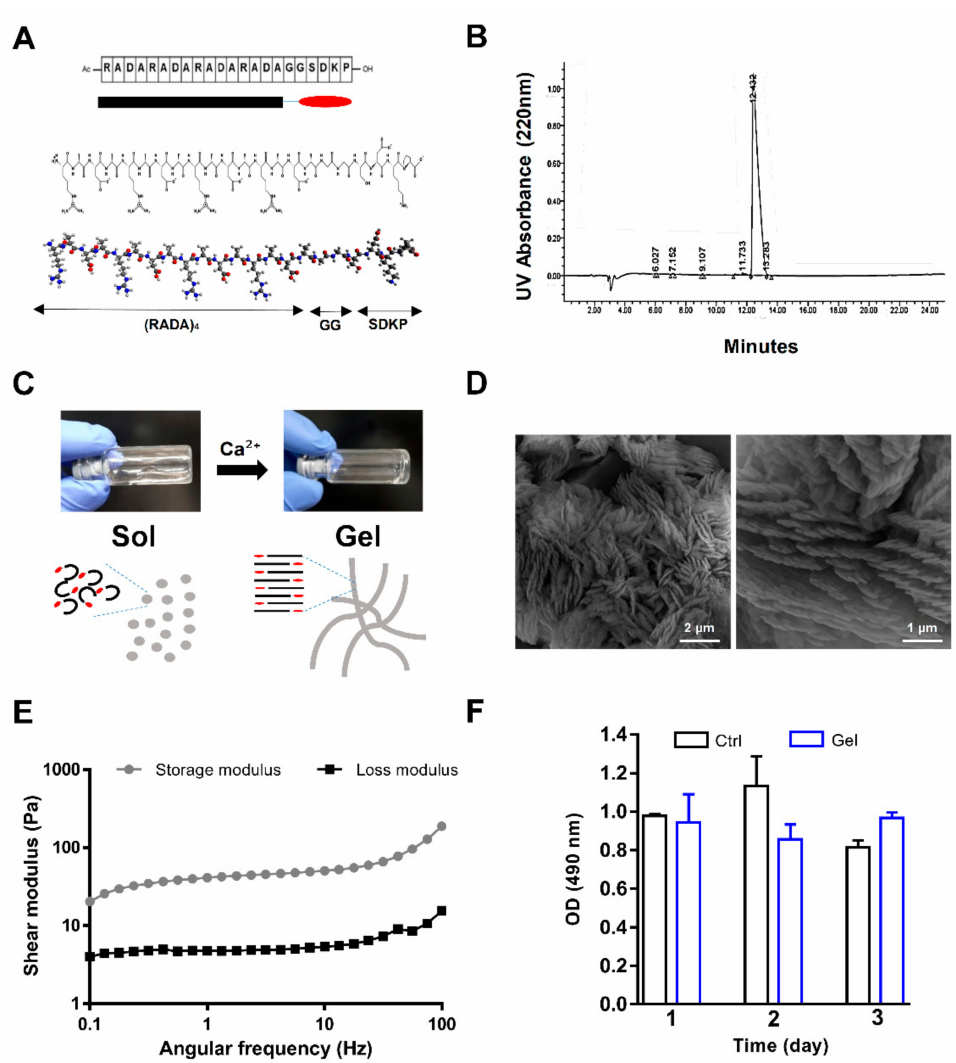
Figure 1. Structure and characterization of the self-assembling peptide (SAP) hydrogel. ( A ) Linear, chemical and three-dimensional structure of the (RADA) 4 -SDKP as a precursor of the SAP hydrogel. ( B ) HPLC graph related to (RADA) 4 -SDKP. ( C ) Visual illustration of gel formation by addition of Ca 2 + to the 0.25% (RADA) 4 -SDKP solution. ( D ) Field emission scanning electron microscope (FESEM) images of 0.25% (RADA) 4 -SDKP hydrogel. ( E ) Viscoelasticity analysis of the 0.25% (RADA) 4 -SDKP hydrogel using shear rheometry. ( F ) MTS assay to test the cellular activity of neonatal mouse cardiomyocytes (NMCMs) after 1, 2, and 3 days of encapsulation in the (RADA) 4 -SDKP. MTS assay was performed in 3 biological replicates, each replicate included 4 repeats. Data are shown as mean ± standard